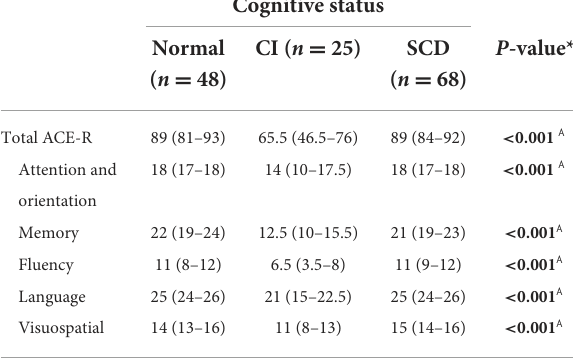
TABLE 3 Total ACE-R and subitens scores comparison in relation of patients cognitive status.